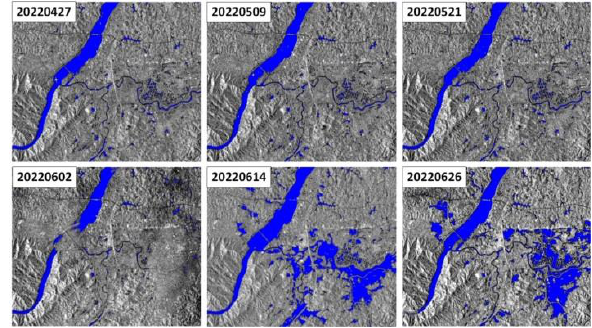
Figure 5 Water body extraction results of